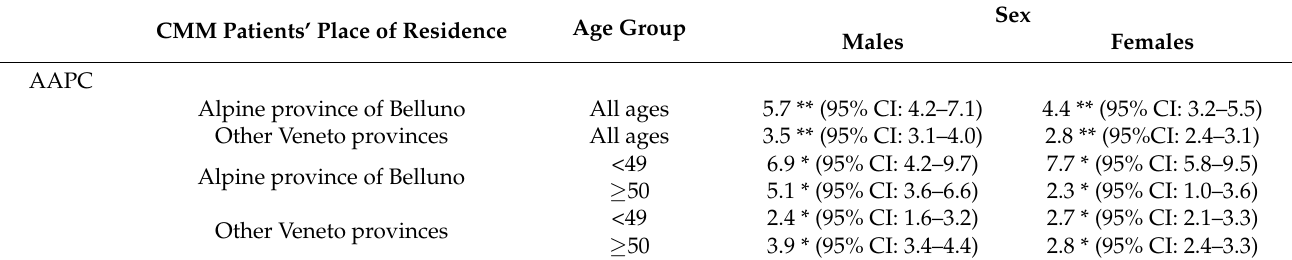
Table 1. Average annual percent change ((AAPC); years 1990–2017) in the population of the Alpine province of Belluno versus the rest of the Veneto population, by sex and age group.